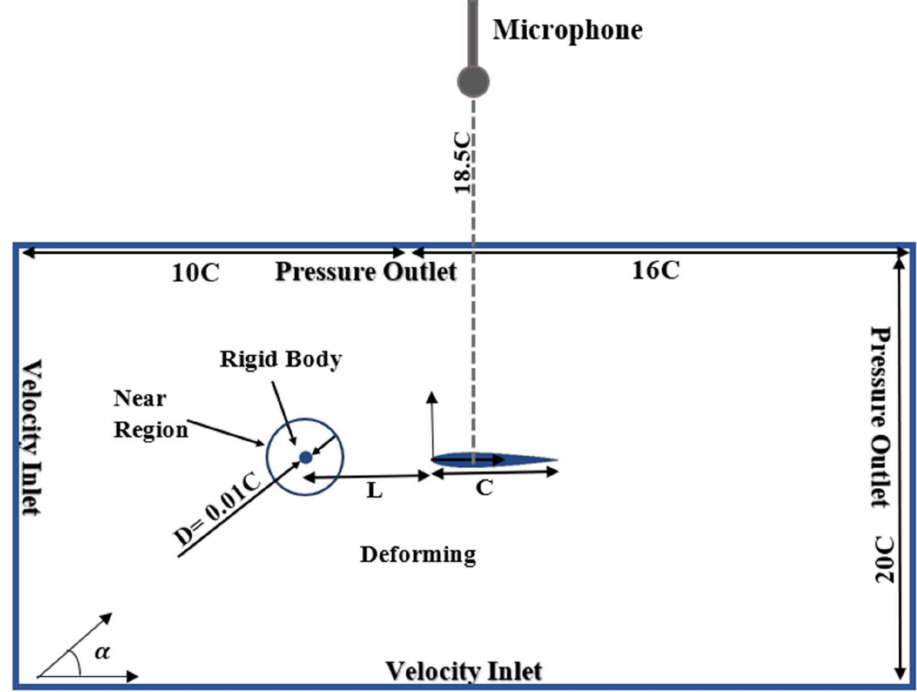
Figure 1. Geometry of the computational domain and boundary